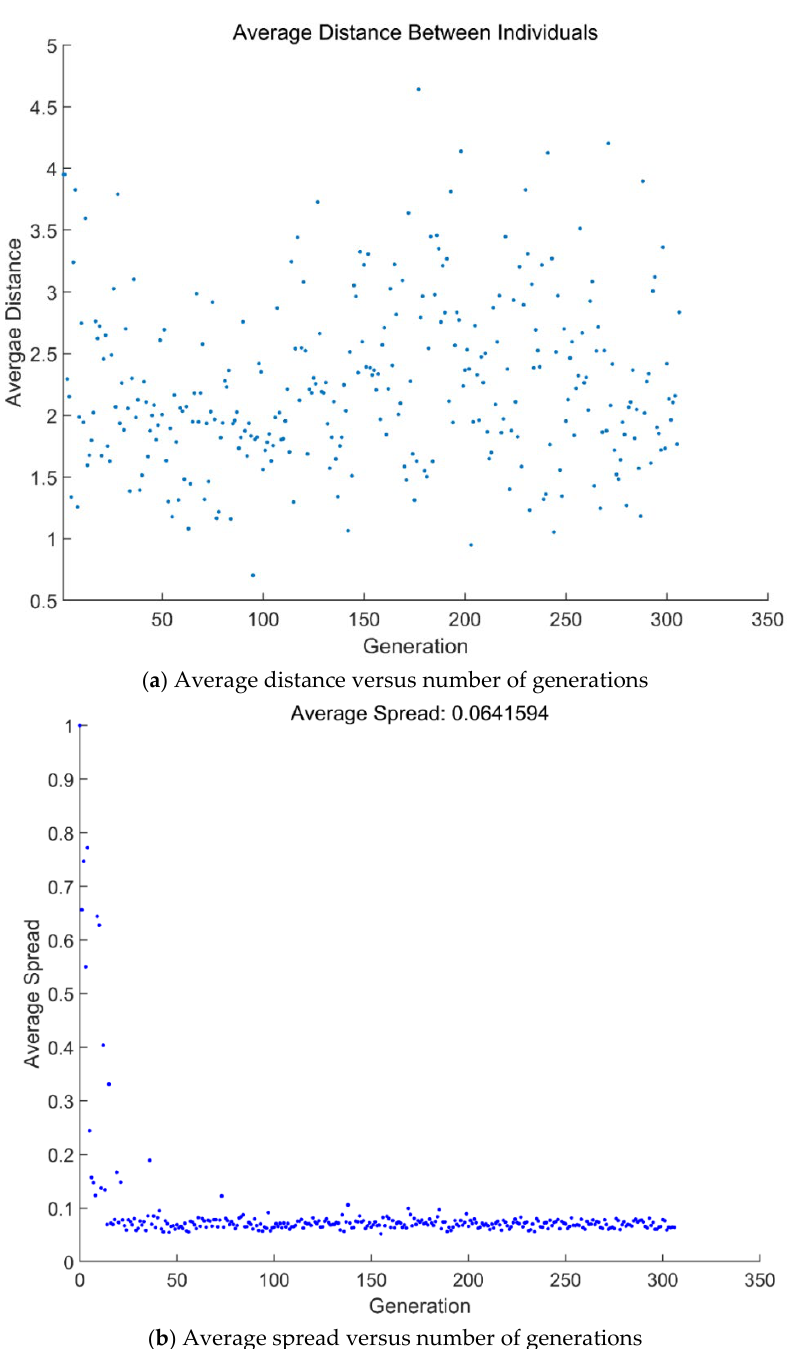
Figure 7. Average distance and average spread versus number of generations ( P − η − E